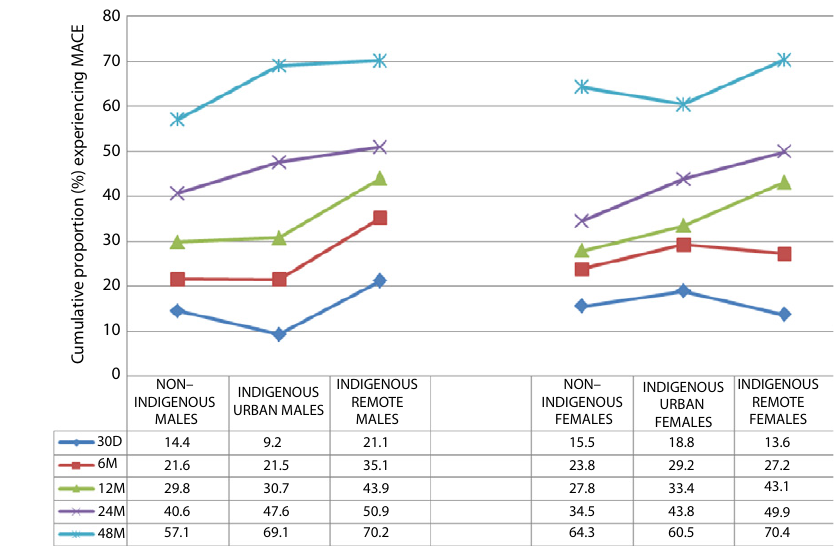
Figure 7. Cumulative prevalence of major adverse cardiovascular events following ACS in the NT (2001–2002) by ethnicity, gender and location (*MACE includes death, non-fatal acute coronary syndrome, stroke or unplanned cardiac